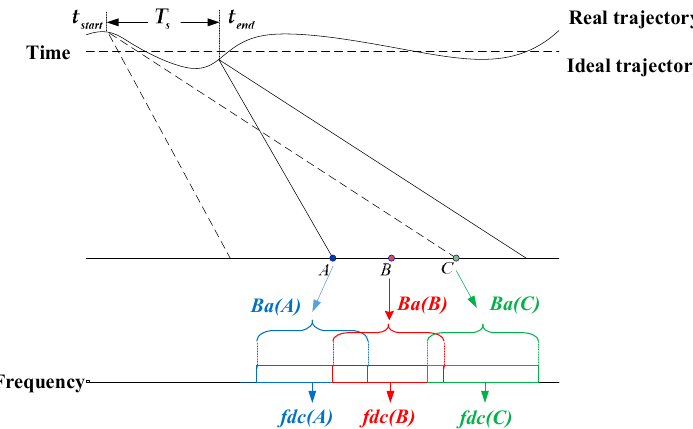
Figure 1. The illumination of the spatially-variant Doppler histories of targets at different positions for the very-high-squint (VHS) airborne SAR imaging. T s is the aircraft motion time. t start and t end are the time start and end, respectively. B a is the Doppler bandwidth. f dc is the Doppler centroid.